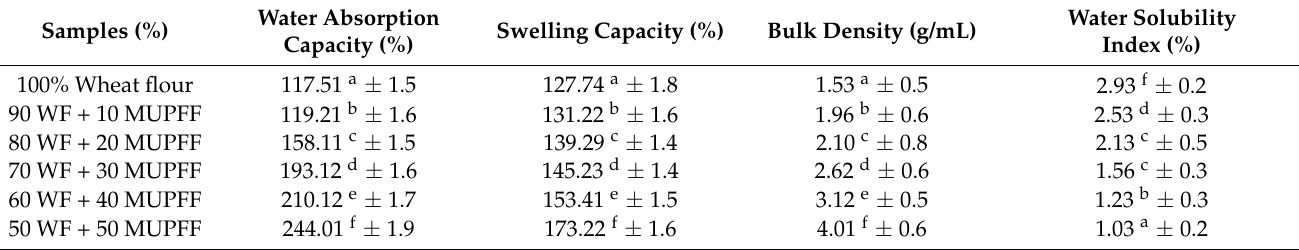
Table 2. Functional properties of composite flour from wheat flour and unripe pawpaw fruit